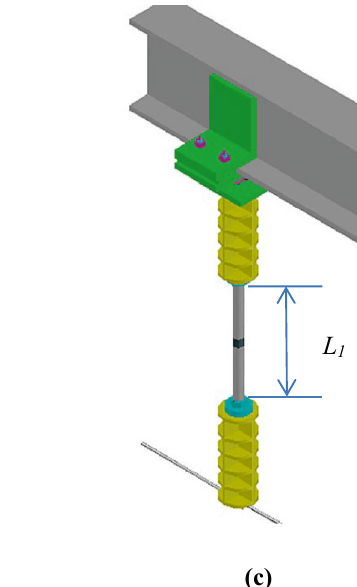
Fig. 2 a Strut display: 1. Bolt, 2. Sleeve, 3. Pressing block, 4. Fixing components, 5. Upper round steel, 6. Retaining nut, 7. Loading block, 8. Loading screw, 9. Lower round steel, 10. Steel strand con-